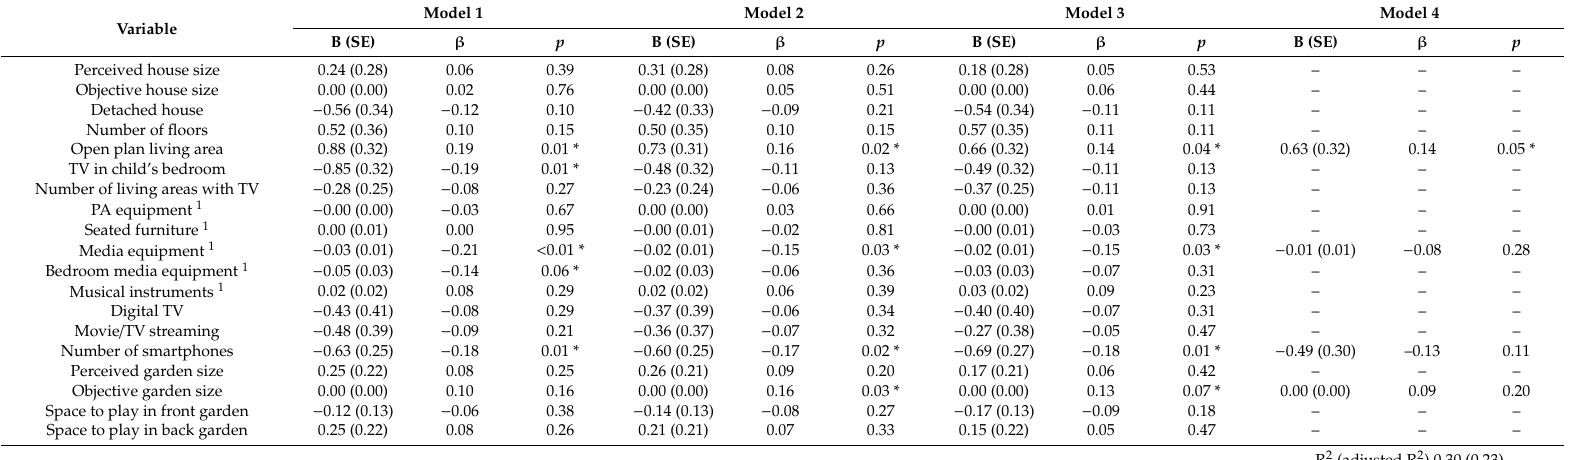
Table 6. Associations between physical home factors and children’s home–based